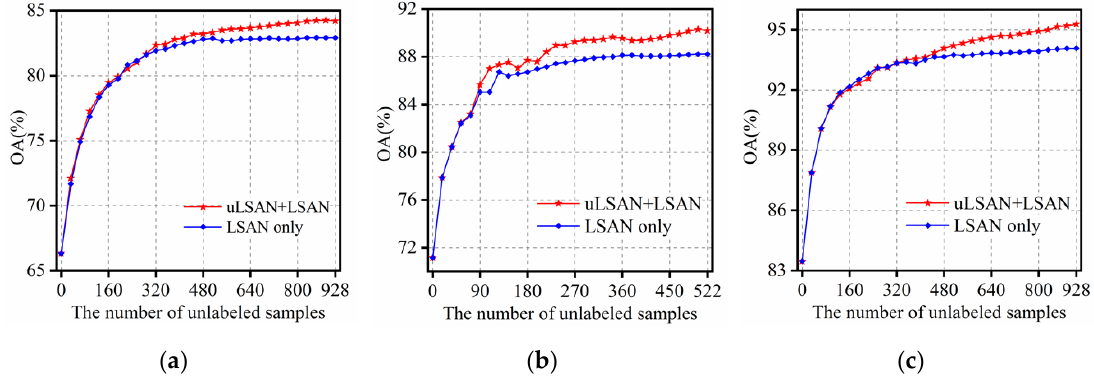
Figure 12. OAs as a function of the number of unlabeled samples with unlabeled samples selected from only LSAN and from uLSAN, LSAN simultaneously for the ( a ) Indian Pines dataset, ( b ) Pavia University dataset, and ( c ) Salinas Valley dataset.